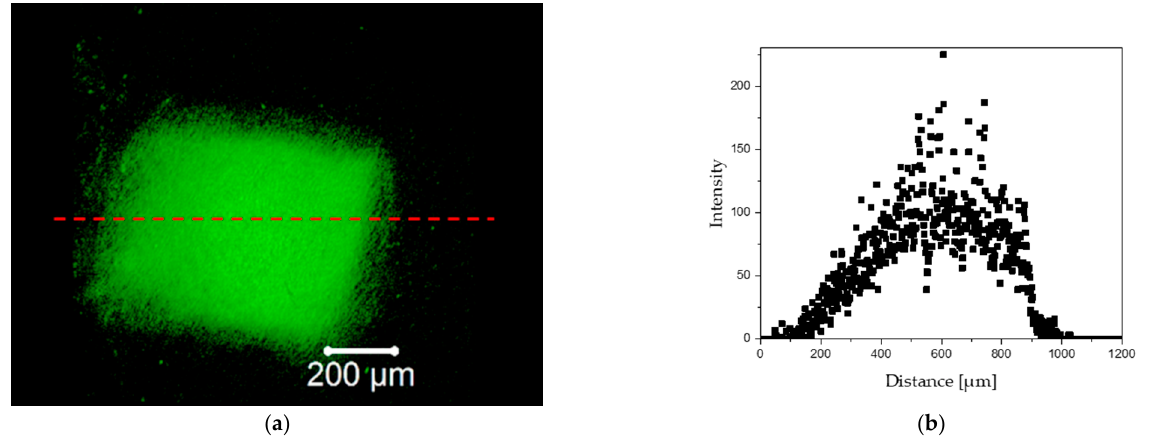
Figure 8. Two second influence of the proton beam on tissue autofluorescence: ( a ) autofluorescence and line scan on fluorescence images; ( b ) intensity of light excited in autofluorescence—increase of autofluorescence at the proton burning site.